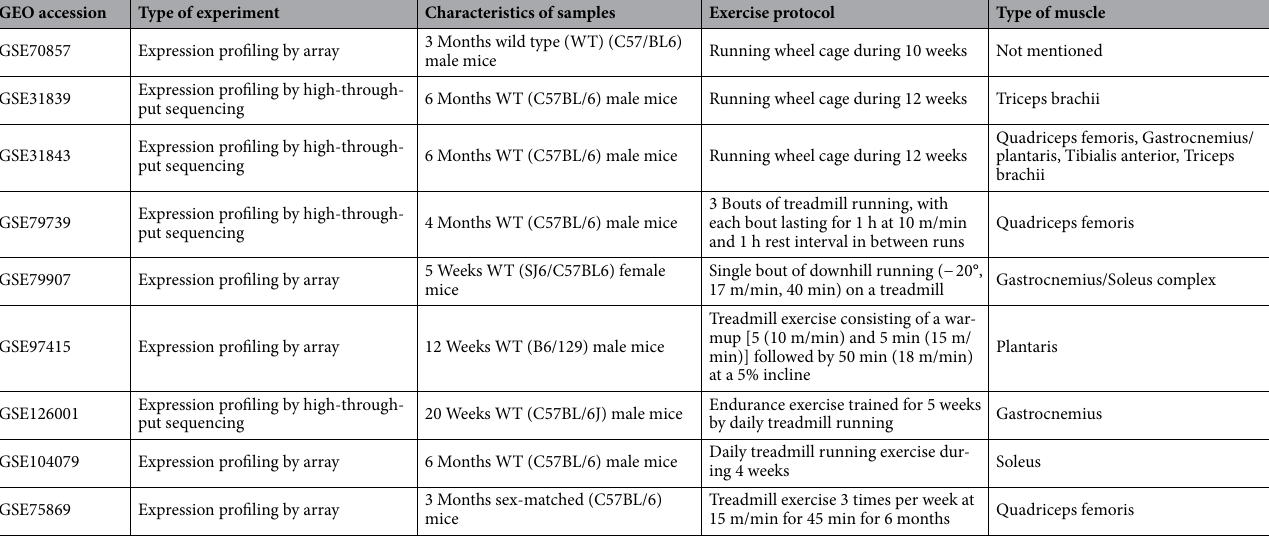
Table 1. Publicly available in vivo